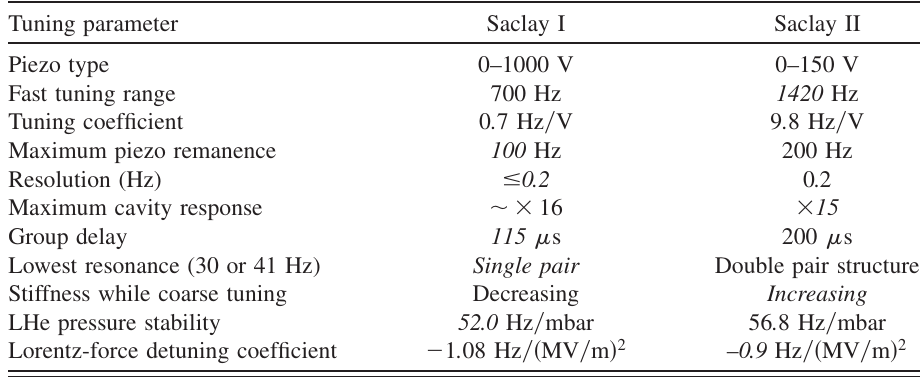
TABLE I. Fast tuning properties of the tested Saclay I and Saclay II cavity tuning systems. The italic type marks preferable properties of the